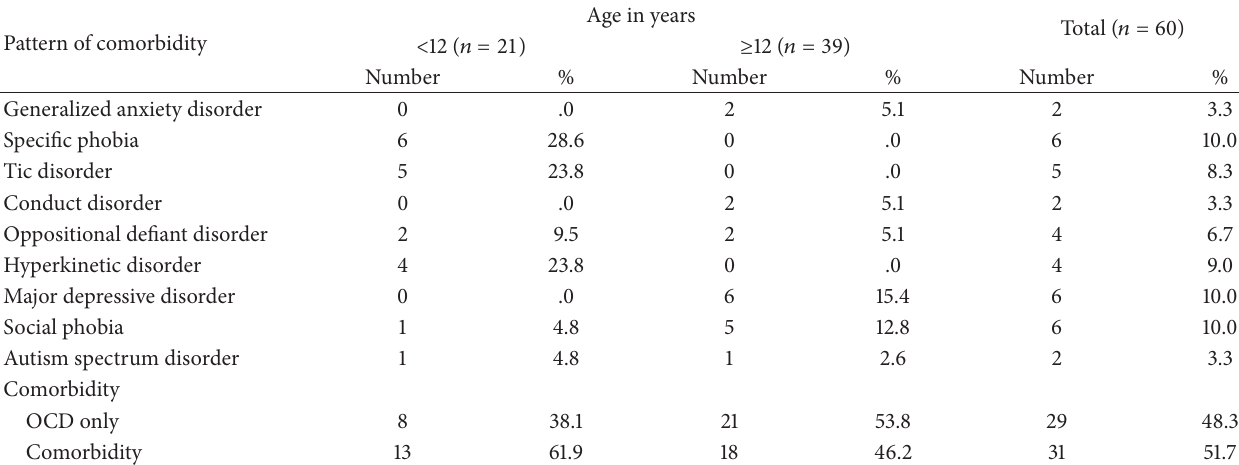
Table 1: Pattern of comorbidity among 8–18-year-old respondents.